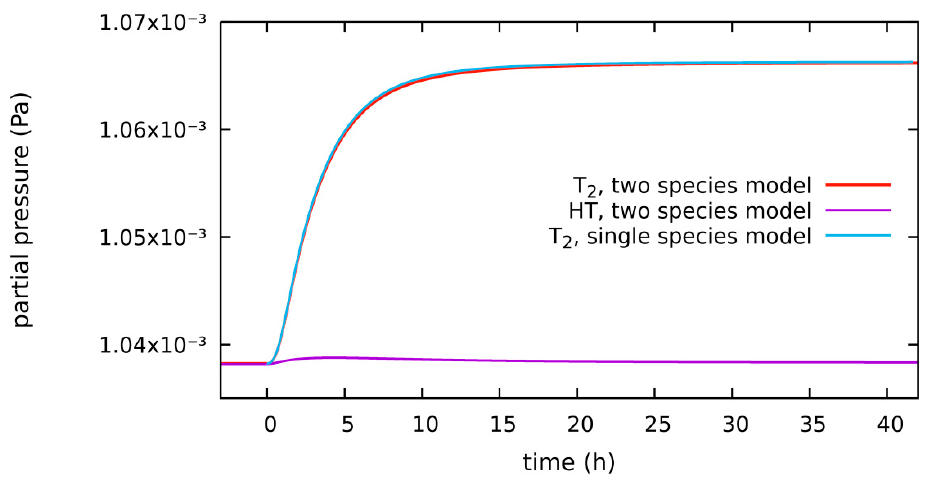
Figure 16. Transient T 2 and HT partial pressures for single- vs. two-species model.